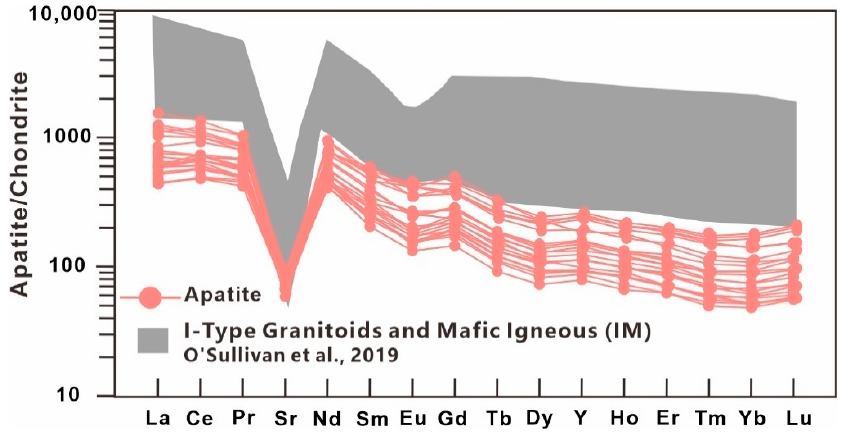
Figure 5. CL image of apatite grains from monzogranite sample 21HK01 ( a ). Apatite Tera– ages for Muniushan apatite U-Pb analyses ( c ).